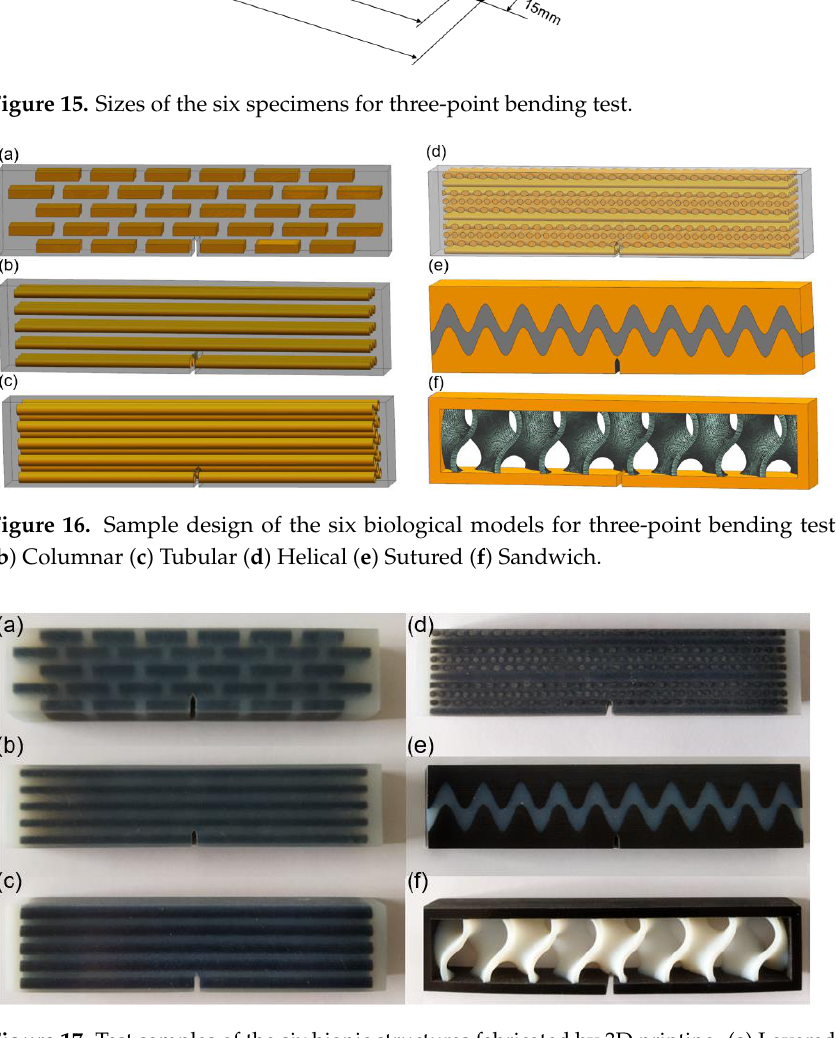
Figure 17. Test samples of the six bionic structures fabricated by 3D printing. ( a ) Layered ( b ) Columnar ( c ) Tubular ( d ) Helical ( e ) Sutured ( f ) Sandwich.